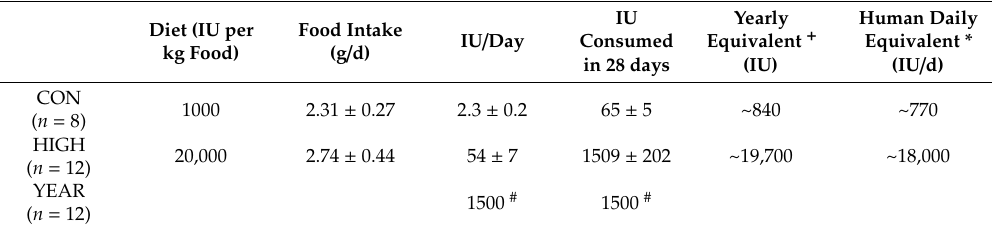
Table 1. Comparison of Vitamin D consumed. Diet (IU per kg